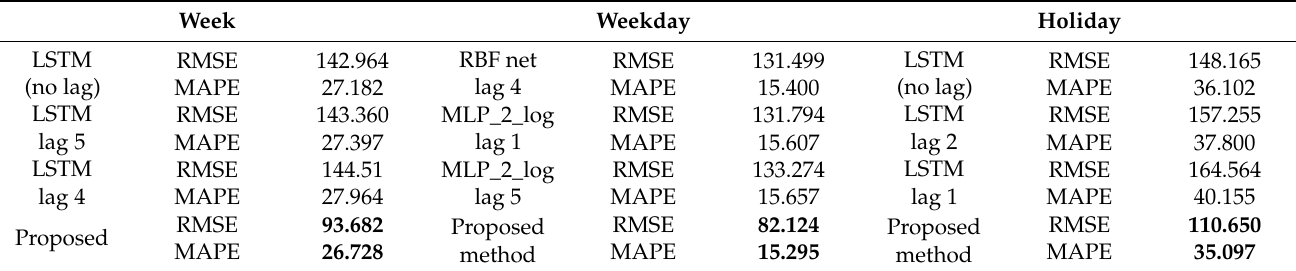
Table 7. Results of proposed model for Route 7 based on minimal